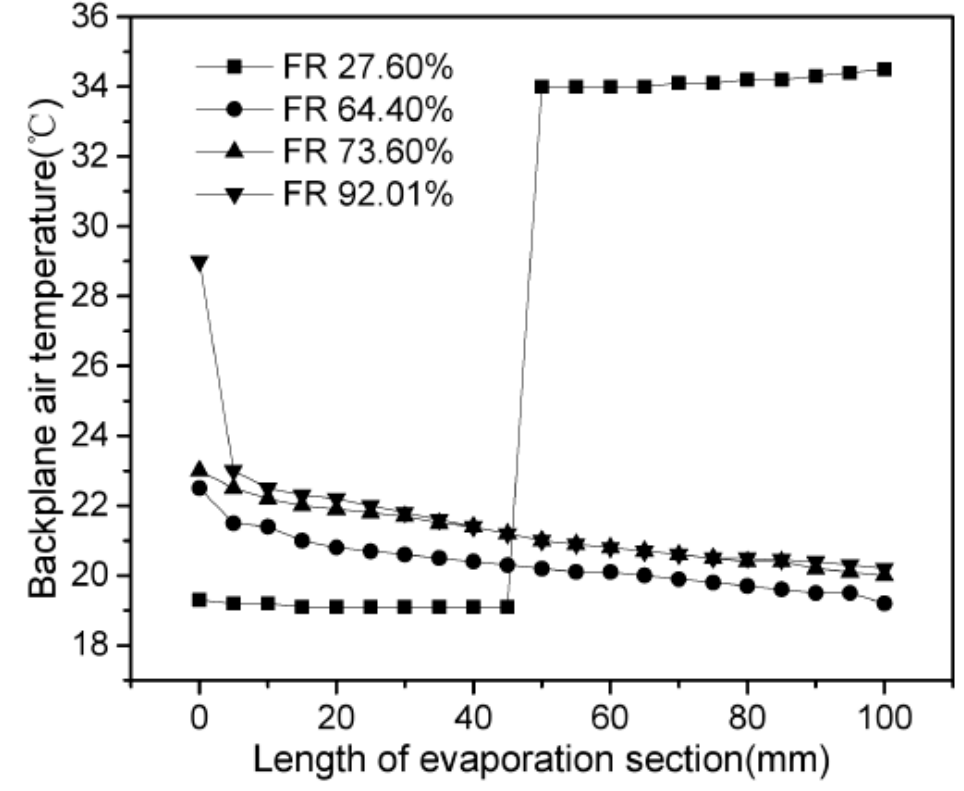
Figure 13. Variation of the temperature of the outlet air along the length of the evaporation section.